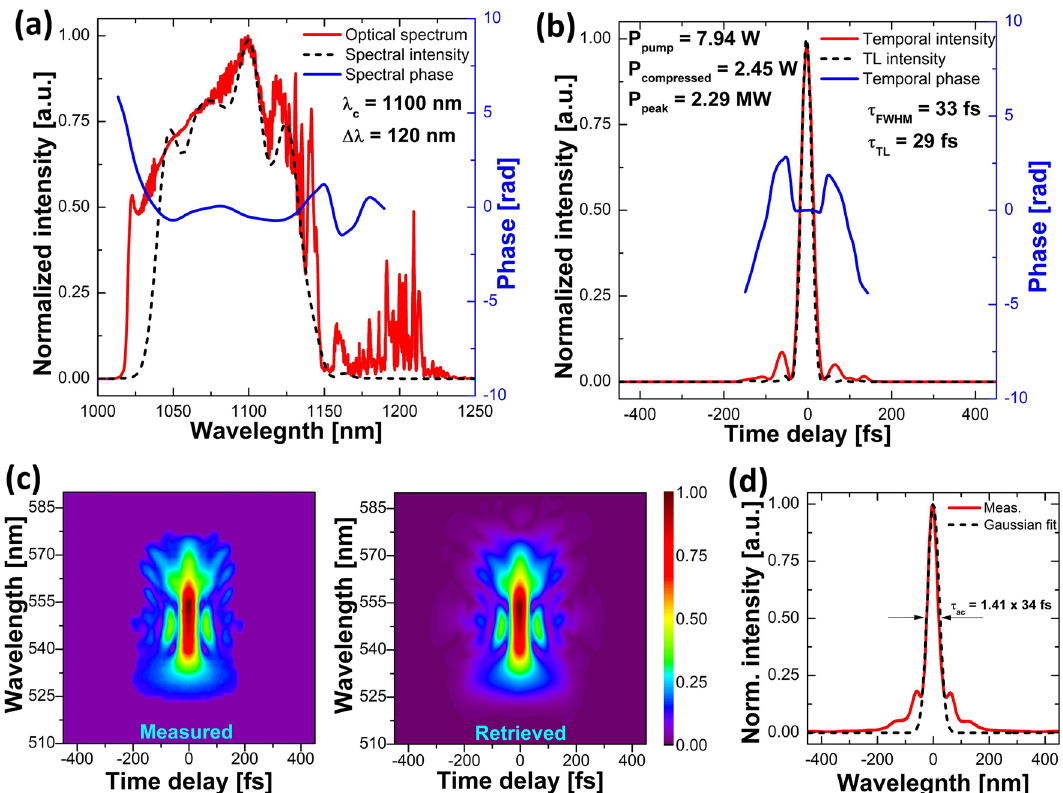
Figure 10. Characterization of the shortest compressed pulse obtained from the GMN amplifier with the low-repetition-rate laser as a seed source: ( a ) optical spectrum measured by the OSA (solid red line) and the FROG-retrieved spectral profile (dashed black line) with spectral phase (solid blue line), ( b ) FROG-retrieved temporal intensity (solid red liane) of the compressed pulse and temporal phase (solid blue line) as well as transform-limited intensity profile (dashed black line), ( c ) measured and retrieved FROG spectrograms, ( d ) autocorrelation trace (solid red line) and Gaussian fit (dashed black